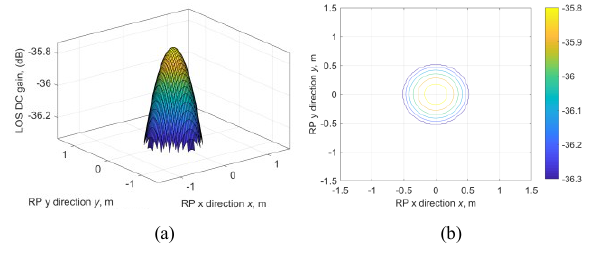
Figure 2 (a) surface plot and (b) contour plot of the LOS DC gain along the receiving plane